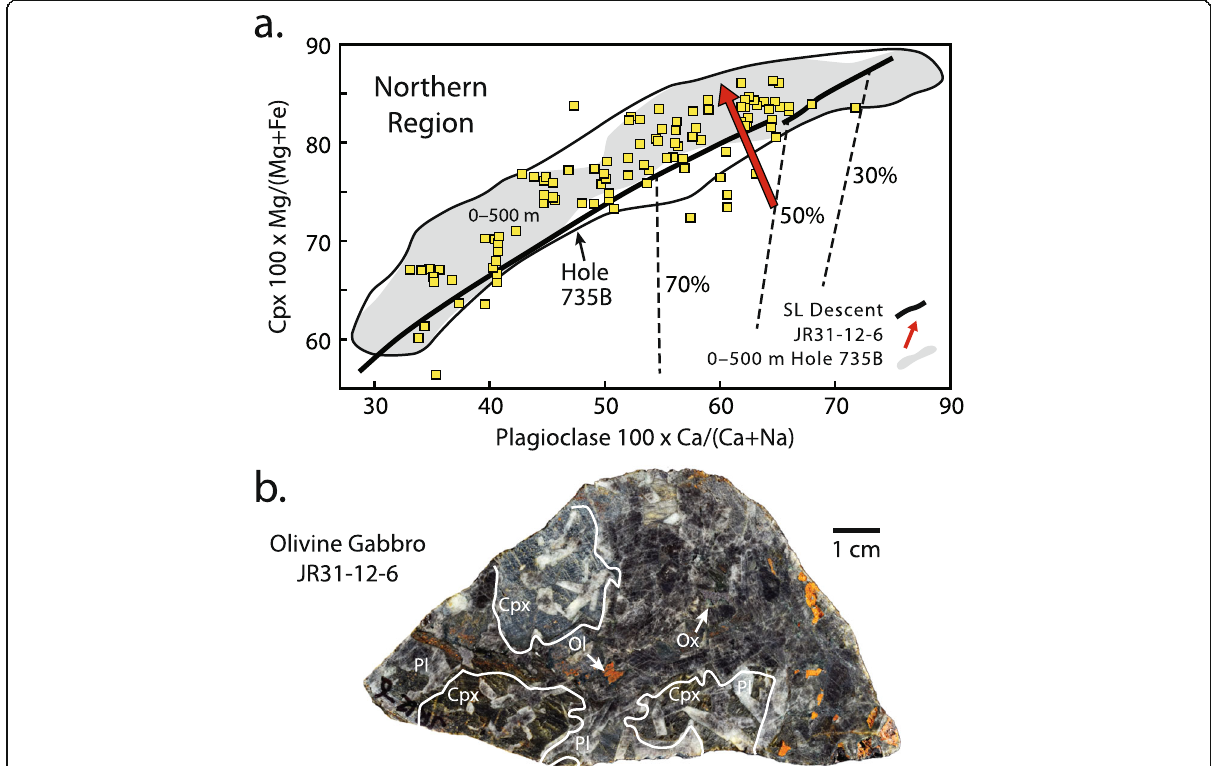
Fig. 47 a Plot of Mg# in augite vs plagioclase anorthite content for the northern seafloor gabbros: red arrow shows the inferred trend between the most calcic and least magnesian and the least calcic and most magnesian plagioclase and augite in oikocrysts in olivine gabbro of JR31-12-6. Solid black line is the line of descent (SLD) for fractional crystallization calculated for a parental melt. The dashed lines, extending from the SLD towards the coexisting melt composition, are labeled with the percent crystallization. Gray-shaded field shows the composition range for the upper 500 m of Hole 735B. b Sample JR31-12-6 showing three euhedral to anhedral, augite oikocrysts (lower left), and plagioclase chadocrysts in pegmatoidal olivine gabbro with ~ 8 – 10% intergranular